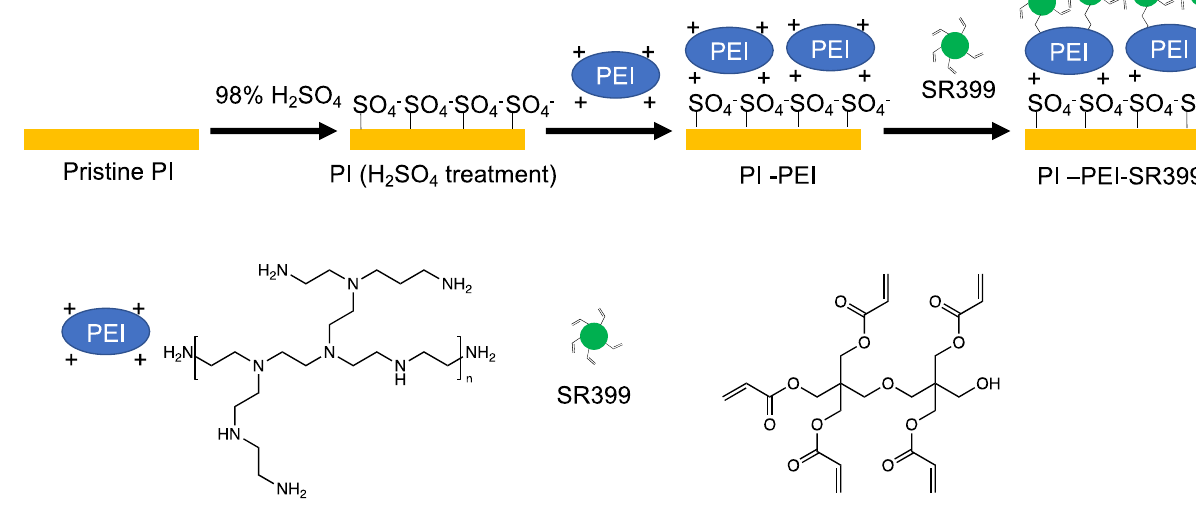
Figure 9. Schematic of surface arylation by PEI on PI.